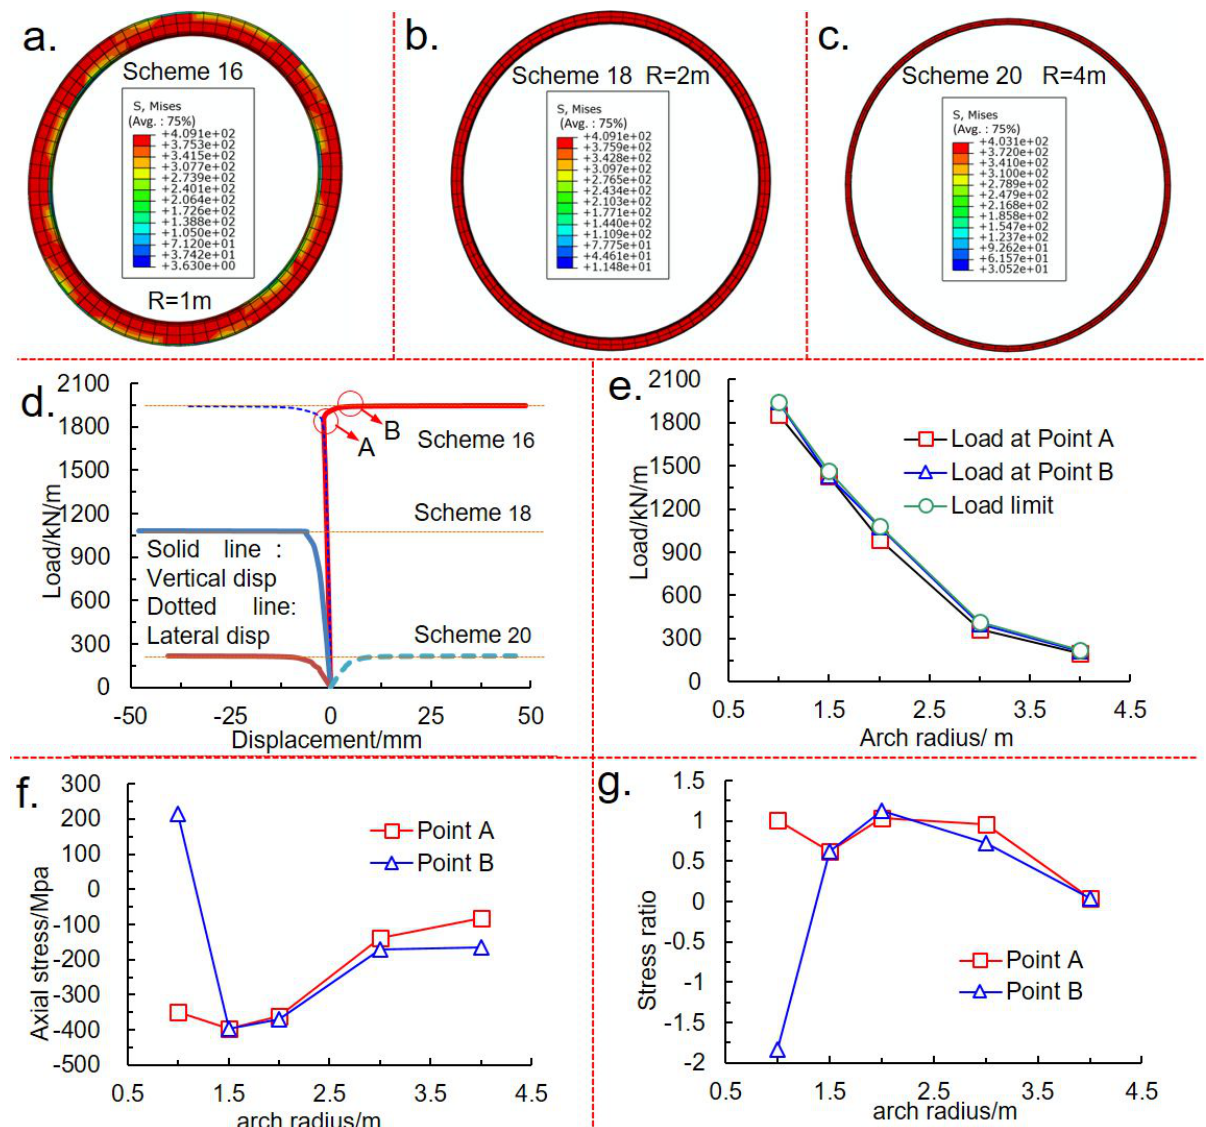
Figure 9: Typical results for Schemes 16–20 with the different arch sizes. (a)–(c) Stress contours and deformed shapes of the arches; (d) Load–radial displacement curves; (e) Characteristic loads influenced by the arch size; (f) Axial stress at the dangerous section, influenced by the arch size; (g) Ratio of the axial stress at the inner and outer sides of the dangerous section, influenced by the arch